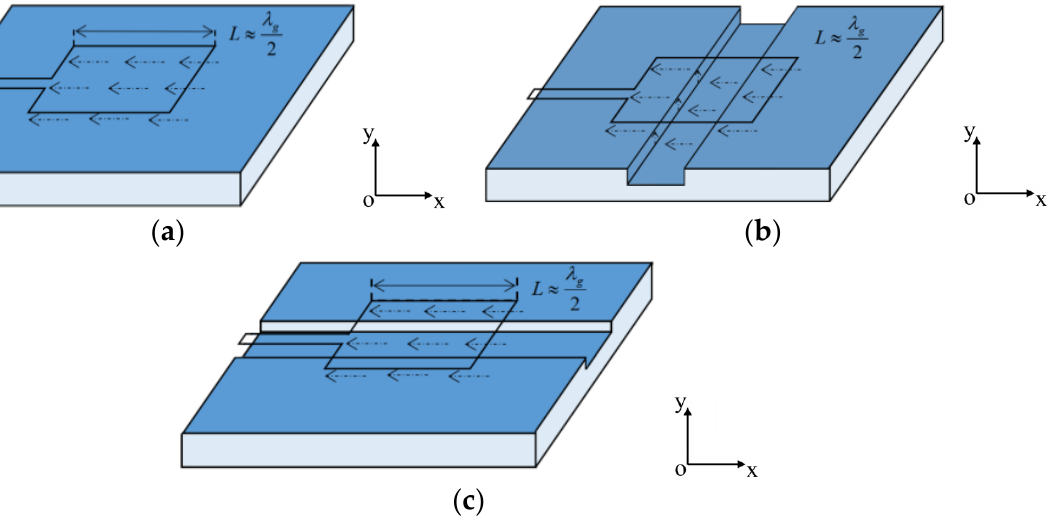
Figure 4. The current distribution of sensor with a single feeding port. ( a ) Current distribution without crack. ( b ) Current distribution with crack along oy axis. ( c ) Current distribution with crack along ox axis.